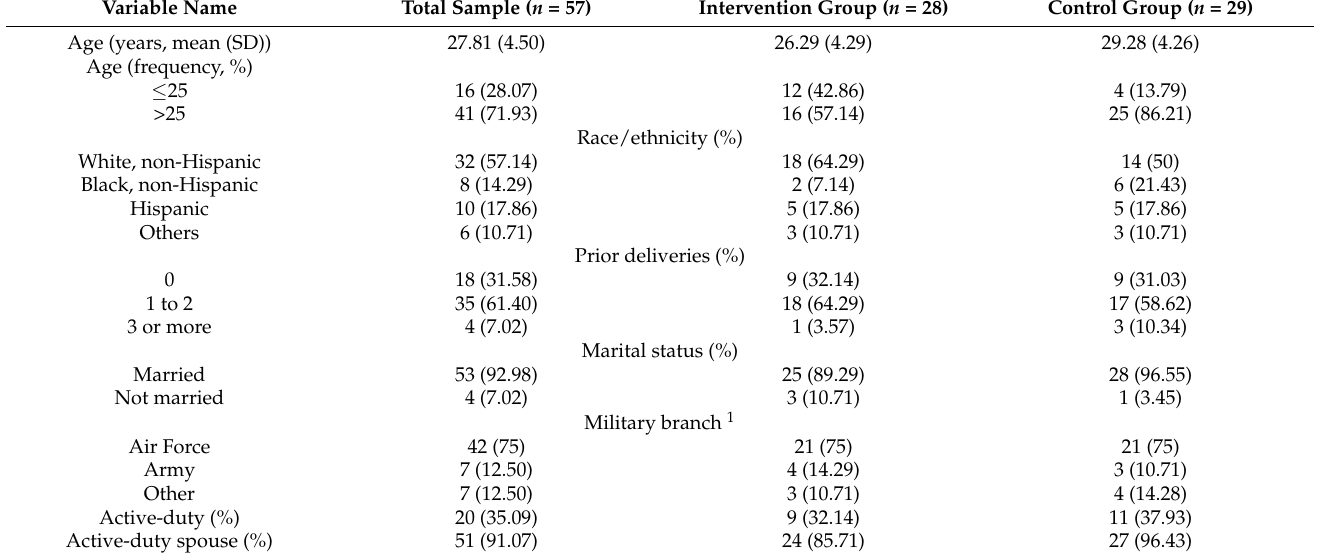
Table 1. Summary of sample